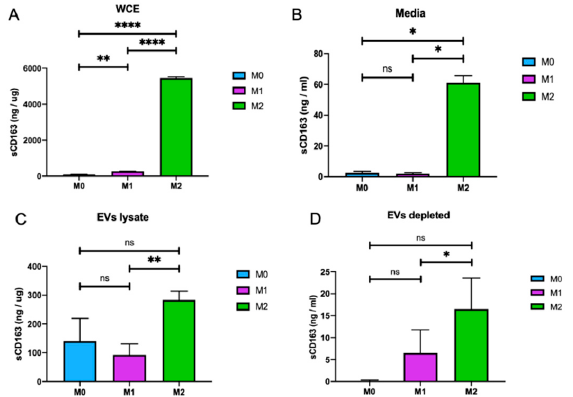
Figure 4. Soluble CD163 (sCD163) is associated with M2-EVs. ( A ) The level of CD163 in whole-cell protein extracts (WCE) from M0, M1, and M2 cells was measured by ELISA and shown as a bar graph. ( B ) Soluble CD163 levels in the growth media of cells from M0, M1, and M2 cells were analyzed by ELISA and shown as a bar graph. ( C ) sCD163 levels in EV lysates isolated from M0, M1, and M2 cells were analyzed by ELISA and shown as a bar graph. ( D ) Soluble CD163 levels in the growth media of cells were analyzed by ELISA after EV isolation (EV-depleted, the remaining growth media of cells from panels B and C after EV isolations). ( n = 3; * p ≤ 0.05, ** p ≤ 0.01, and **** p ≤ 0.001).